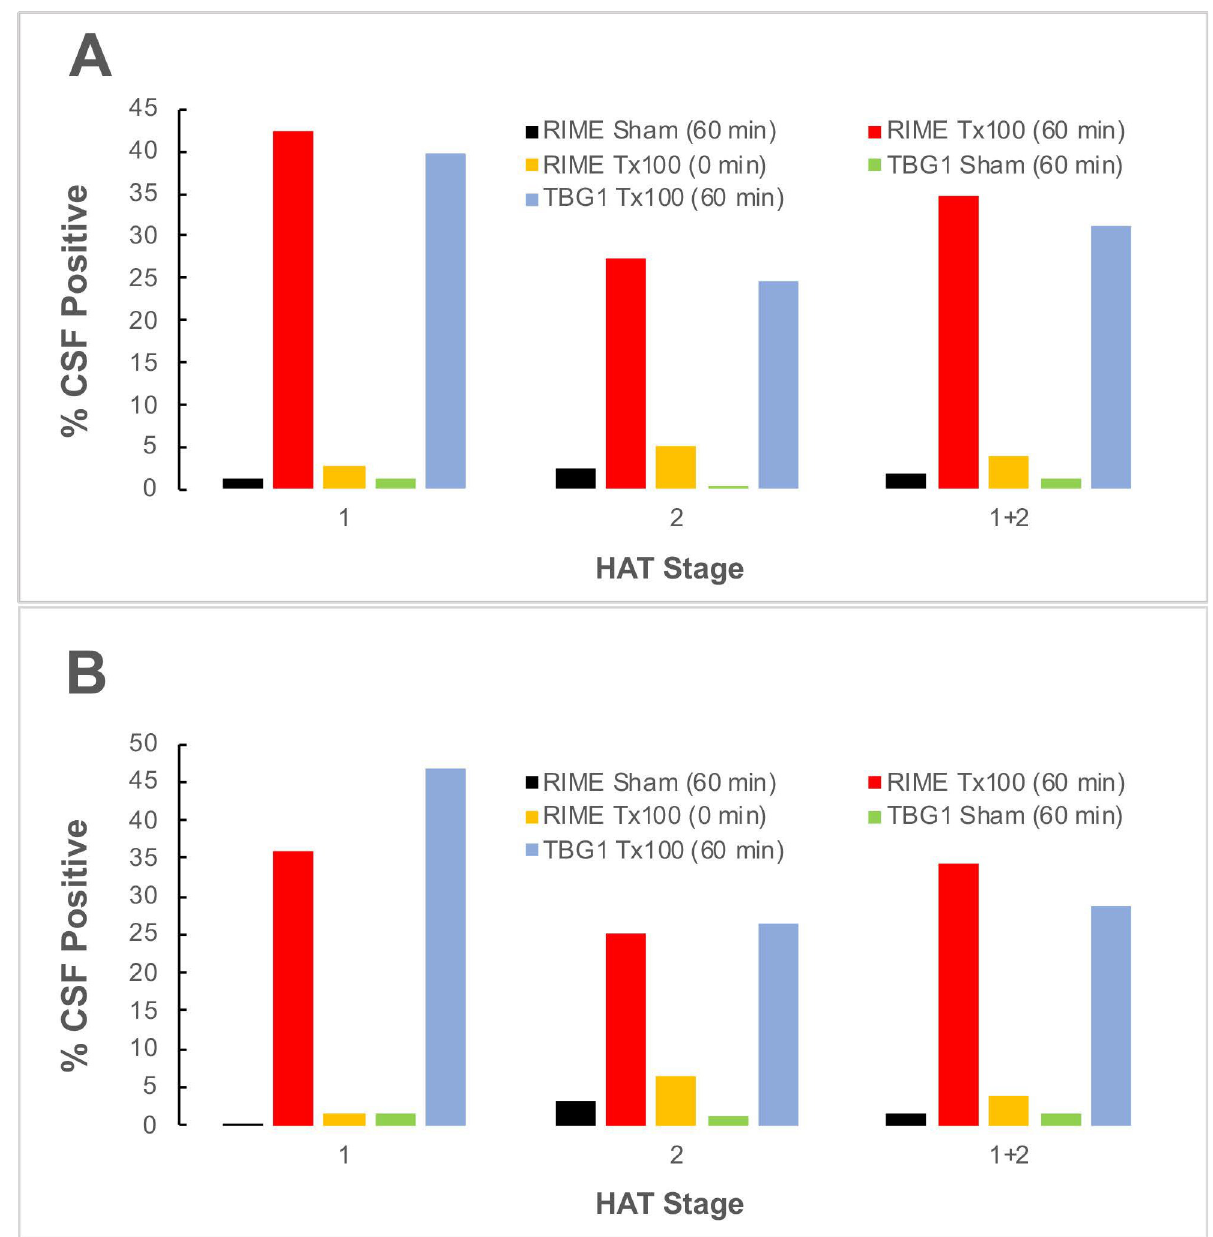
Fig 1. Percentage (%) of CSF samples positive for trypanosome DNA by RIME and TBG1 LAMP based on Table 1 data.